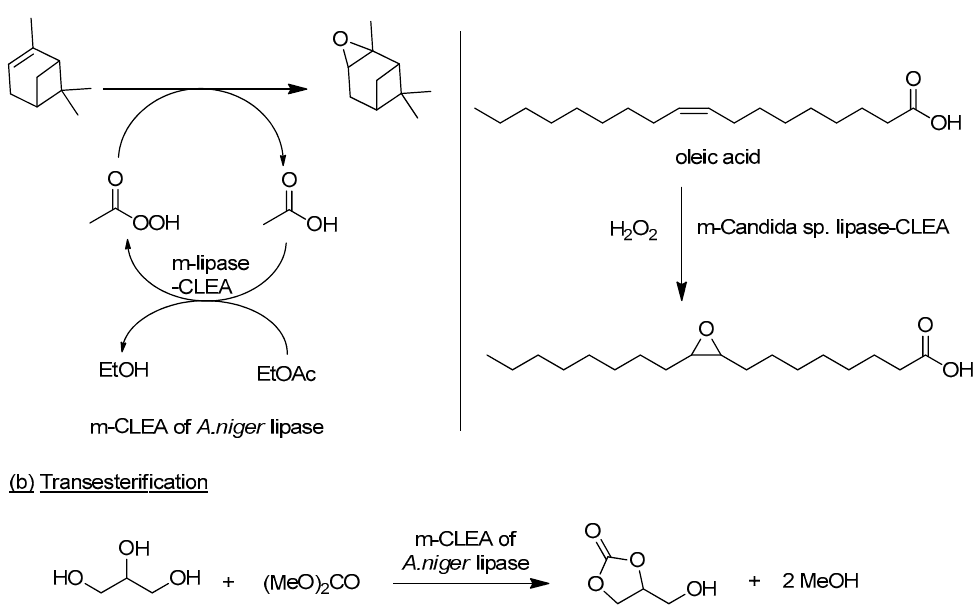
Figure 13. Lipase-m-CLEA catalyzed epoxidation and transesterification.